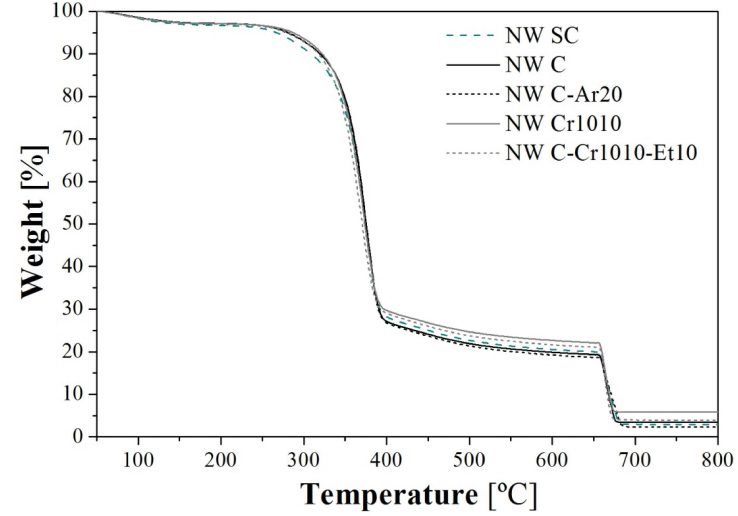
Figure 10. TGA curves of selected samples. Curve NW C-Ar20 can be considered the representative curve for all Ar-plasma-treated samples (NW C-Ar5, NW C-Ar10, NW C-Ar30, NW C-Ar5-Et5, and NW C-Ar5-Et10) due to their